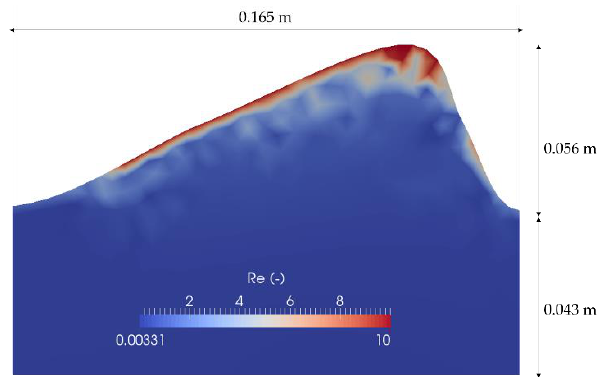
Figure 13. Reynolds numbers at a sandy ripple for case 6.